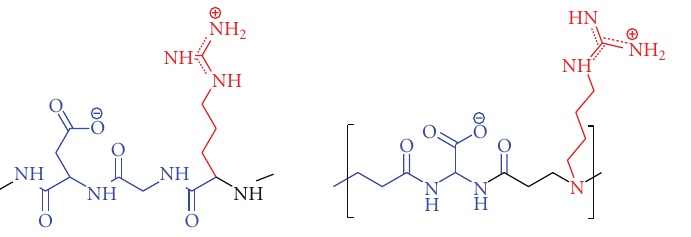
Figure 1: Structure of agmatine containing amphoteric poly(amidoamine) (right part) compared to the RGD tripeptide sequence.